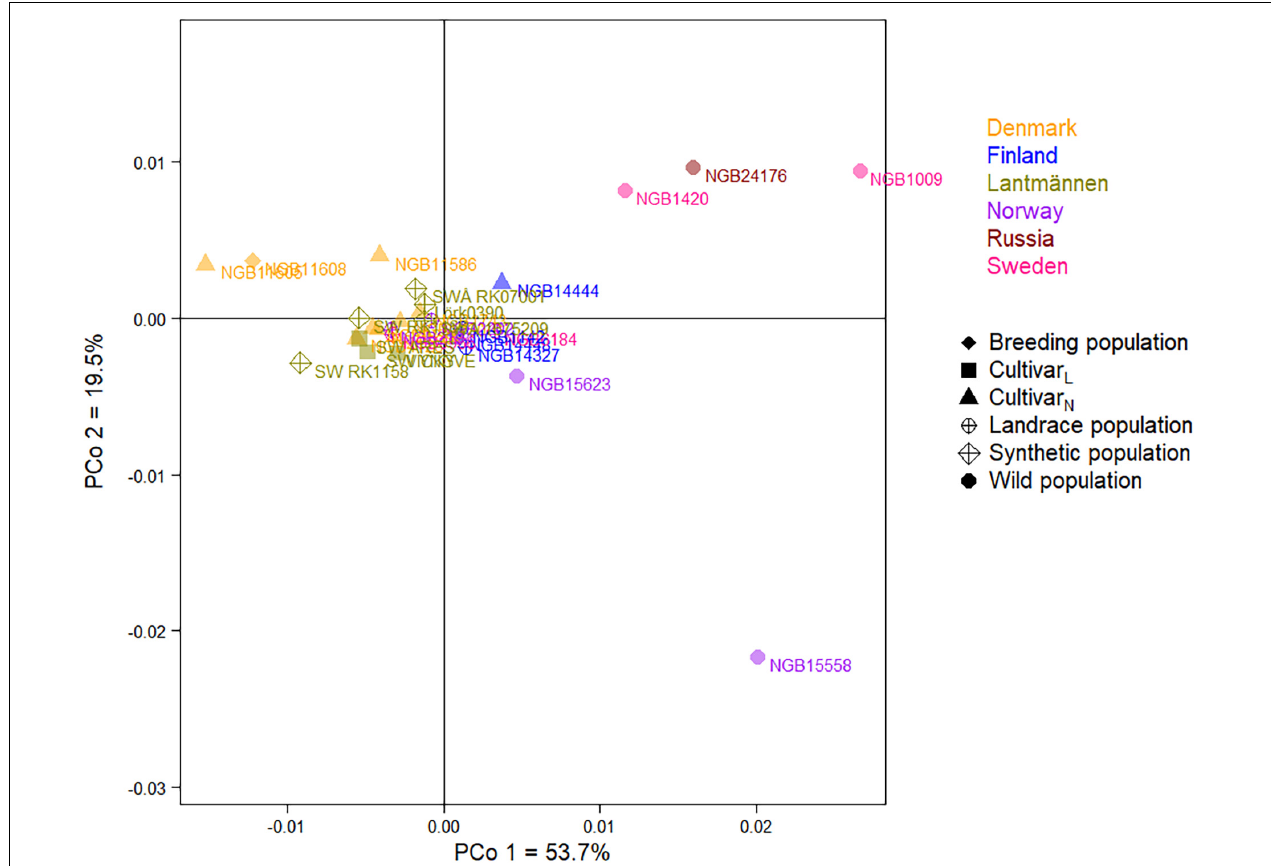
FIGURE 6 | A principal coordinate analysis (PCoA) plot depicting the relationship between the 29 red clover accessions. Accessions with the same font-color belong to the same origin (a country or Lantmännen; see Figure key). Accessions with the same label-shape and color belong to the same population type (see Figure